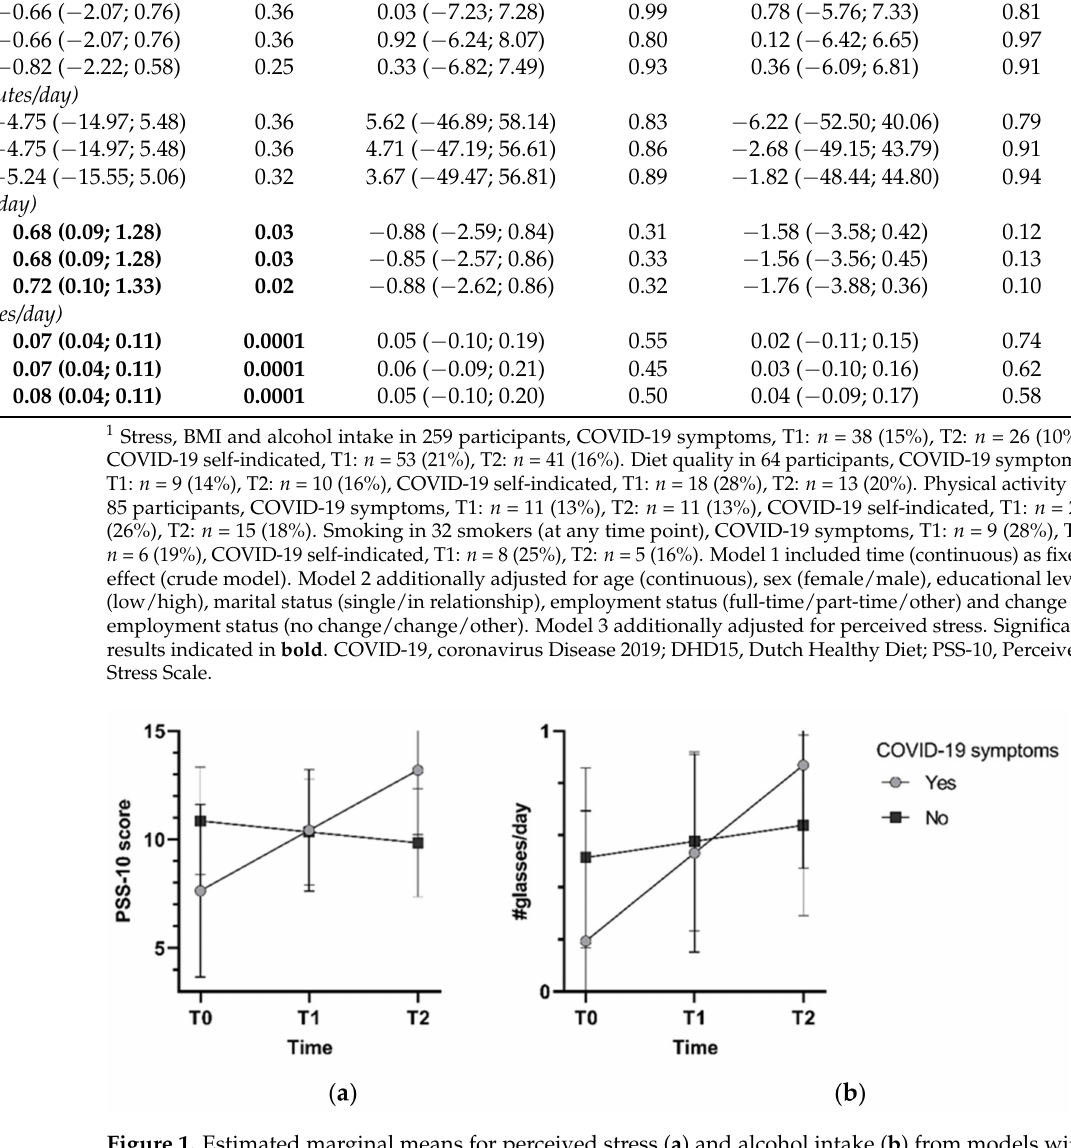
Figure 1. Estimated marginal means for perceived stress ( a ) and alcohol intake ( b ) from models with an interaction of time and COVID-19 symptoms, adjusted for sociodemographic